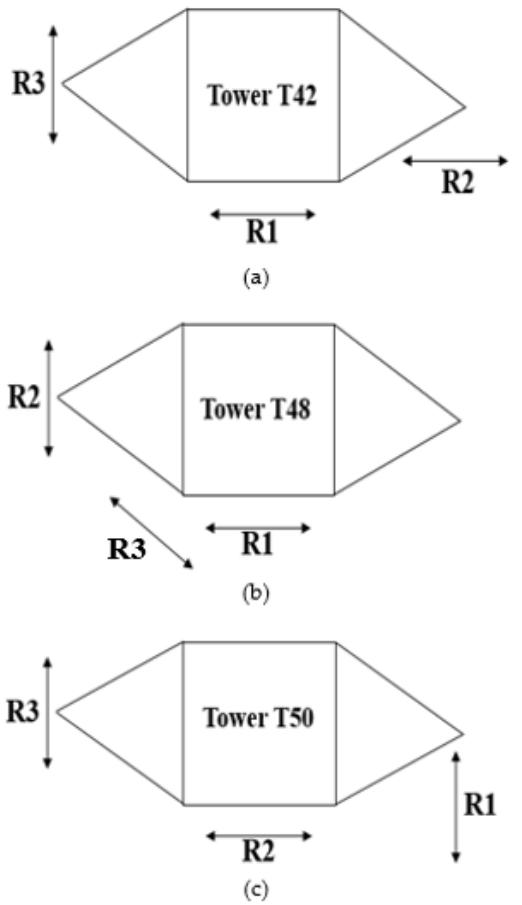
Figure 2. Top view: Apparent resistance measurements at the different location areas; ( a ) Tower T42; ( b ) Tower T48; ( c ) Tower T50.